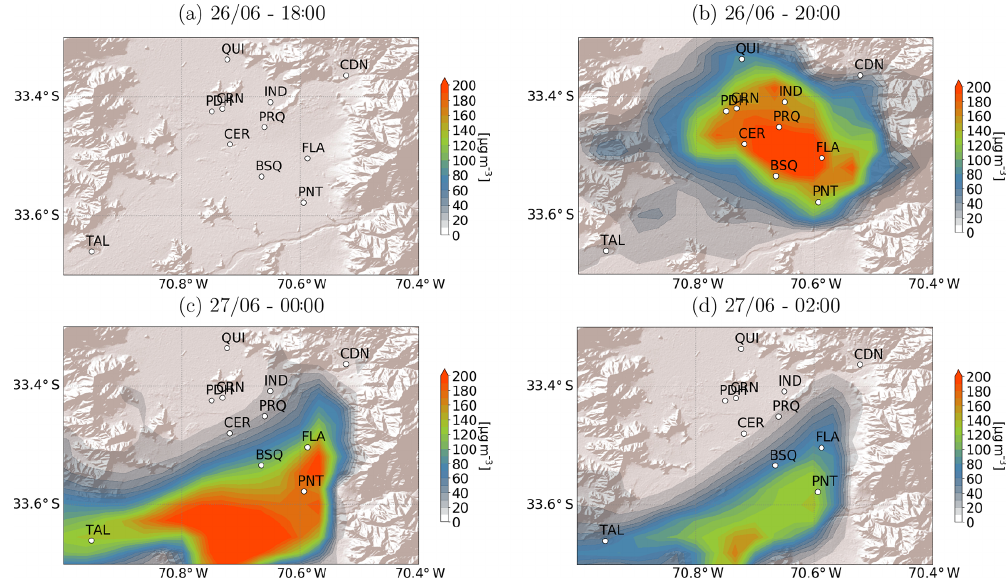
Figure 11. PM 2 . 5 concentration difference at 60m above the surface between the peak event and baseline simulation on 26–27 June. Positive values indicate excess concentrations in the peak event scenario compared to the baseline. Map background layer: World Shaded Relief, © 2009